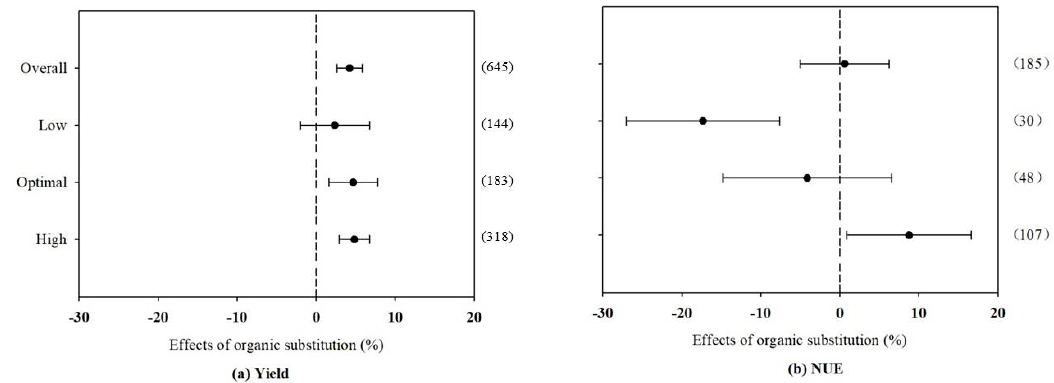
Figure 1. Effects of substitution of mineral fertilizer with organic fertilizer (under three fertilization rates; see main text for definitions of the low, optimal, and high fertilization rates) on maize yield ( a ) and nitrogen use efficiency (NUE) ( b ). Error bars represent 95% confidence intervals. Numbers in parentheses indicate the numbers of observations.